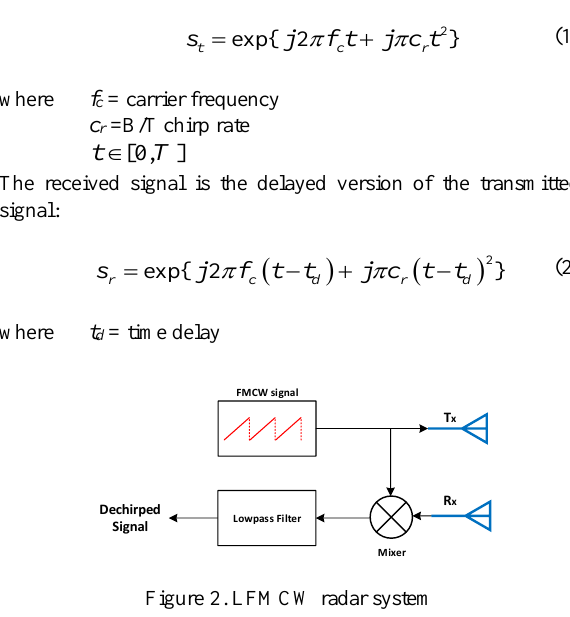
Figure 2. LFMCW radar system